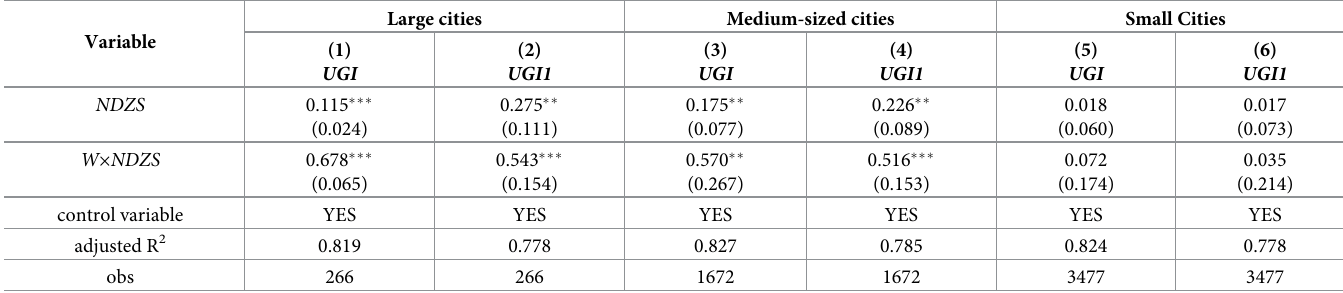
Table 4. Results of the city size heterogeneity